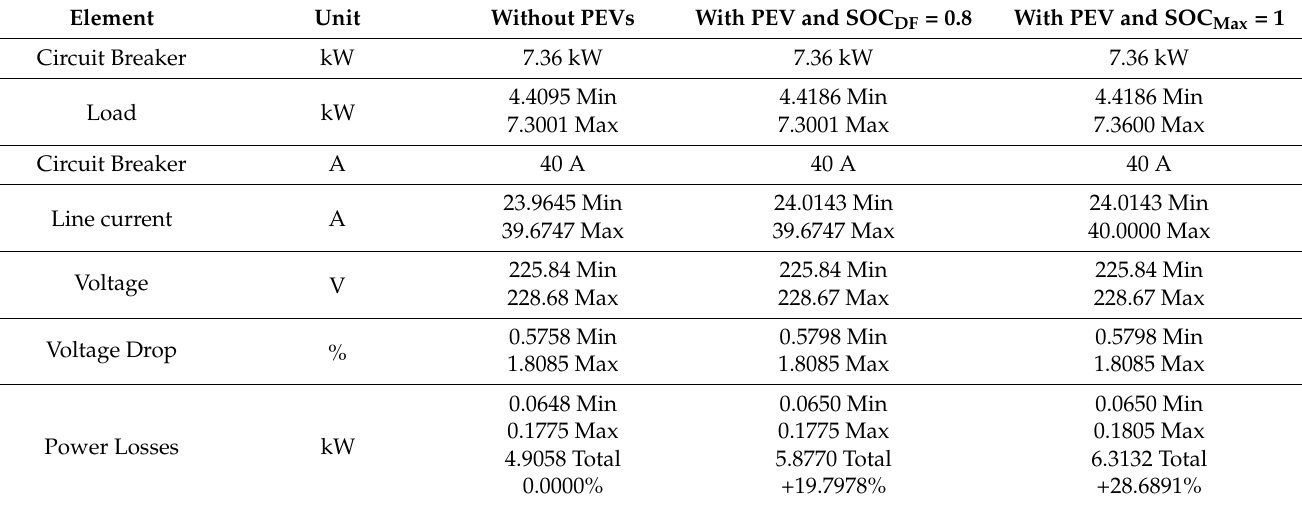
Table 3. Power demand and loss, current and voltage at home (dynamic